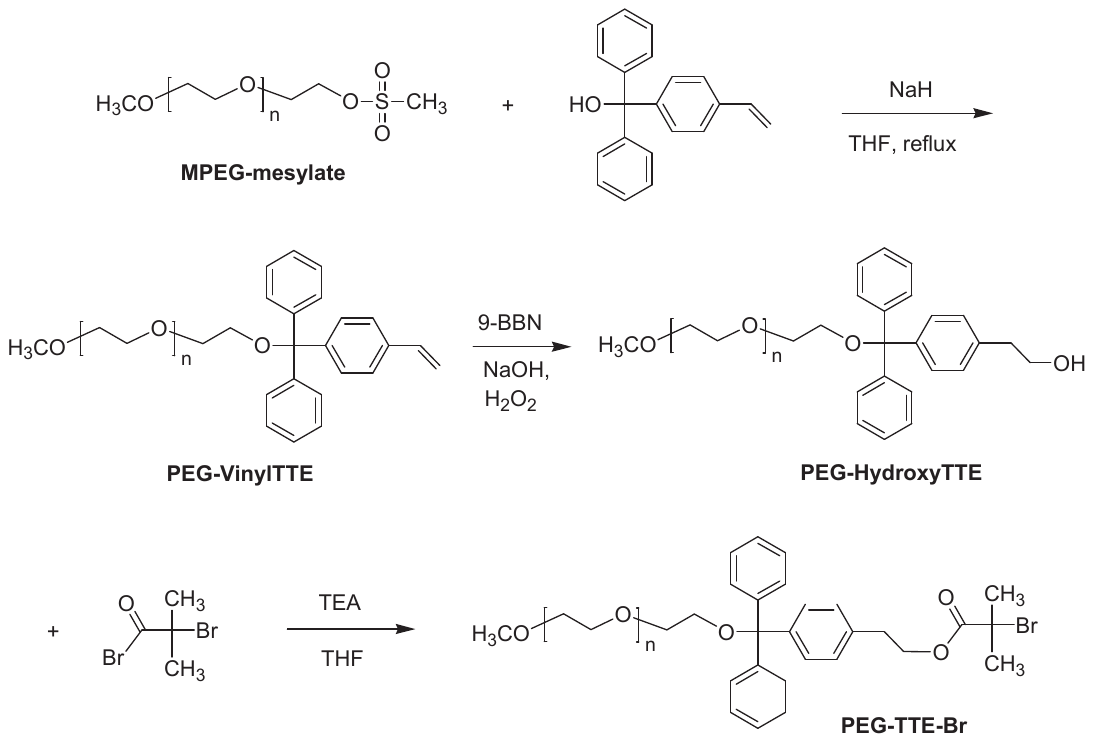
Scheme 1: Synthesis of ATRP macroinitiator